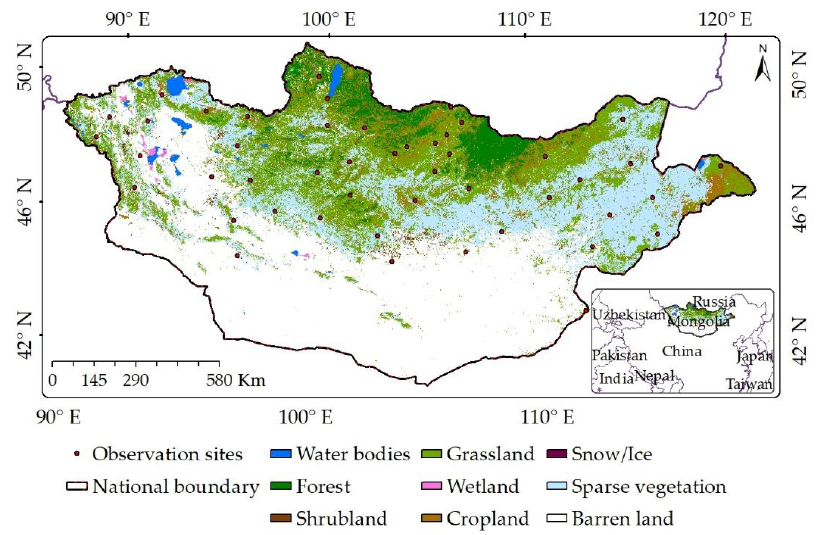
Figure 1. Territory of Mongolia, its locations in Asia, distribution of observation sites, and land coverage.